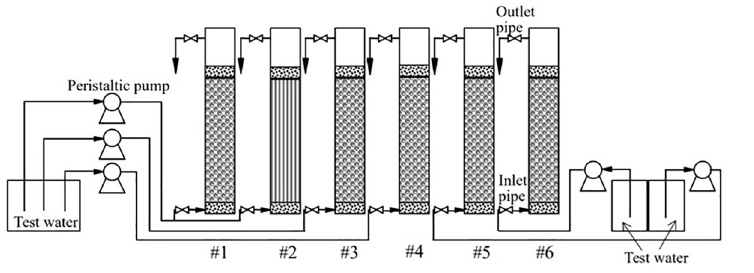
Fig 1. The dynamic test